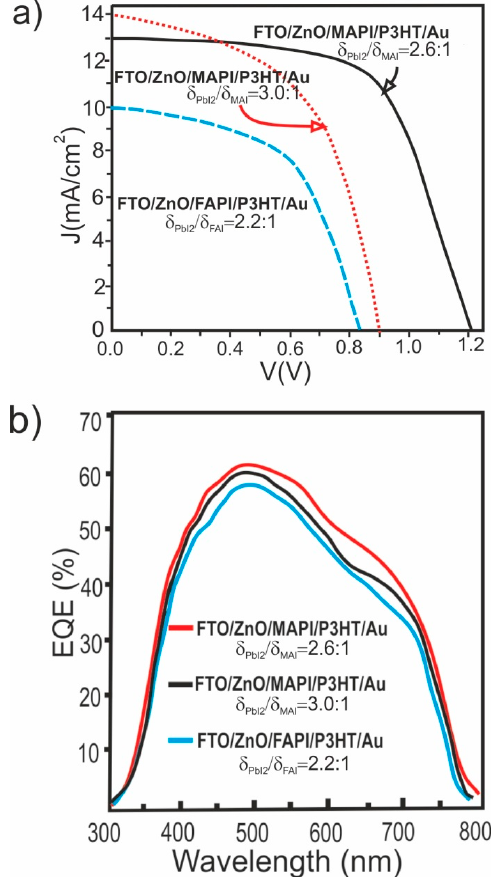
Figure 13. ( a ) J–V curve and ( b ) external quantum e ffi ciency, of the best solar cell fabricated with structure FTO / ZnO / MAPI / P3HT / Au and FTO / ZnO / FAPI / P3HT / Au. δ PbI 2 / δ MAI : PbI 2 / MAI thickness ratio and δ PbI 2 / δ FAI : PbI 2 / FAI thickness ratio. Table 3. Influence of the thickness and composition of the active layer of perovskita on the performance parameters ( Jsc , V OC , FF and η ) of solar cells fabricated with structure FTO/ZnO/Perovskita/P3HT/Au.